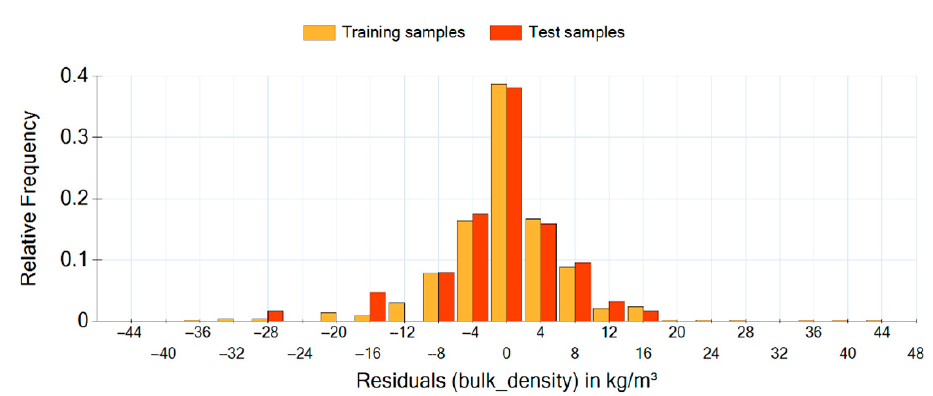
Figure 15. Residual histogram for bulk density estimation.